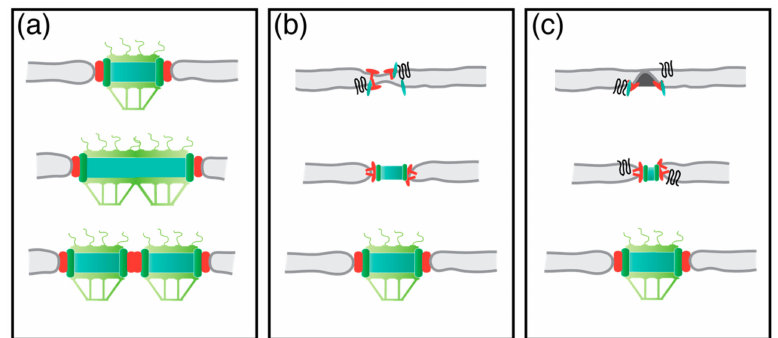
Figure 5. Different models of NPC biogenesis. Model in ( a ) shows the growth of one NPC, which will later split into two. Model ( b ) demonstrates the simultaneous deformation of the NE from the in- and outside. Model ( c ) illustrates the inside-out assembly of a NPC. The POM-anchorage complex is illustrated in red; green, nucleoporins (Nup) components; black, membrane shaping